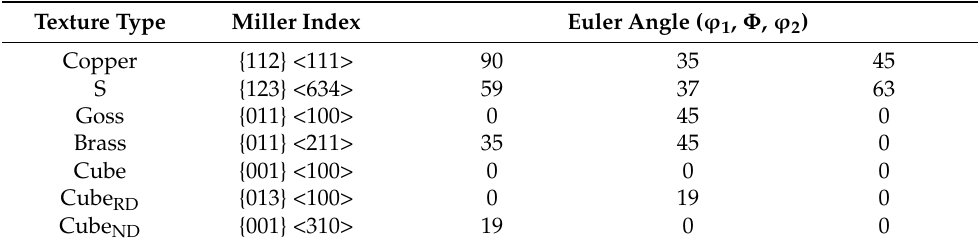
Figure 5. Typical orientation position in ( ϕ 2 = 0°, 45°, 65°) sections of FCC structure materials. Table 3. Main texture component of FCC metals.